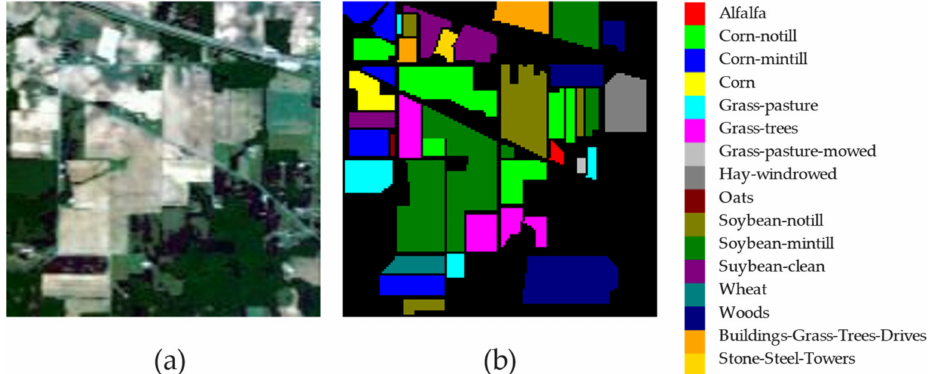
The false-color map and ground truth map of Indian Pines dataset are shown in Figure 9.